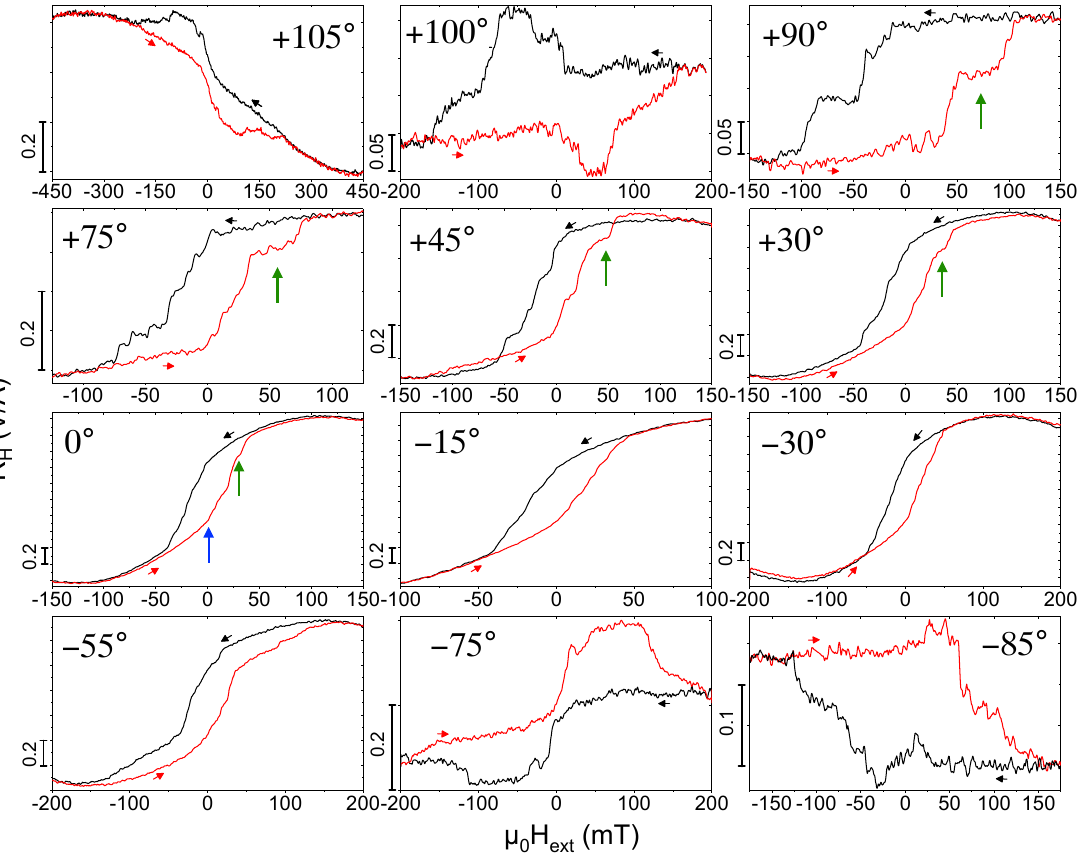
Figure 4. Angular dependence of the magnetic hysteresis loops at T = 30K shown as R H µ 0 H ext for CoFe nano-cubes, obtained for the indicated values of the angle θ of the external applied magnetic field relative to the surface normal of the Hall sensor. Note the varying scales of stray field and external field axes. Black and red arrows indicate down- and up-sweep curves, respectively, following initial saturation at positive field values. Blue and green arrows indicate characteristic switching events and magnetization configurations described in the